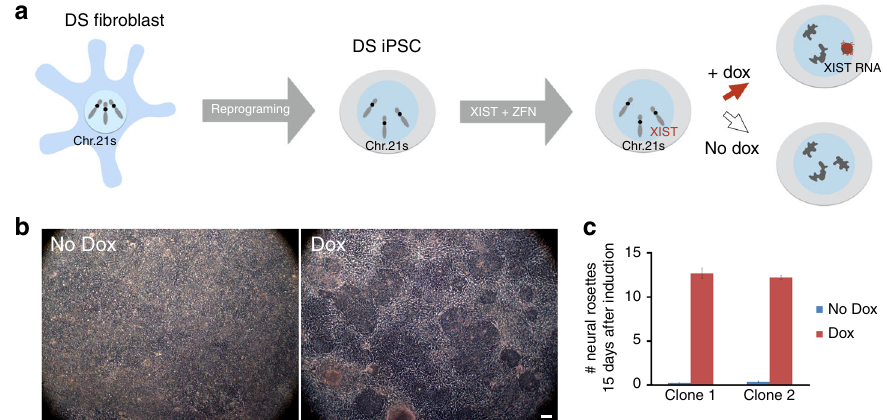
Fig. 1 System to study the effect of trisomy 21 expression on DS-related pathologies. a Schematic of the inducible XIST RNA-mediated silencing system in Down syndrome iPSCs, in which XIST induces formation of a condensed, heterochromatic chromosome 21 “ Barr Body ” . b Neural stem cell (rosette) formation after 15 days neural differentiation, with and without induced expression to silence one chromosome 21. The samples treated with dox have signi fi cantly more neural stem cells at this time point. Scale bar: 100 μ m. c Quanti fi cation of the number of neural rosettes at day 15 for two of the isogenic XIST -transgenic subclones. The iPS cells used were from a male, but because regulatory counting elements are removed from the XIST cDNA, this system is also compatible with female cells. Error bars represent s.e.m. from three independent